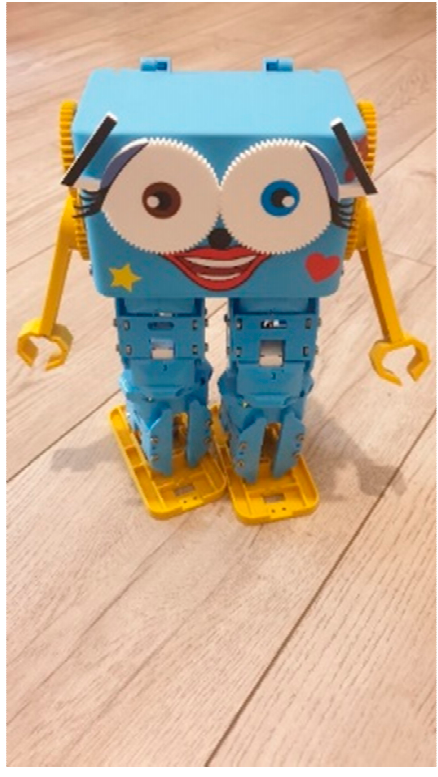
Figure 17. Marty robot.